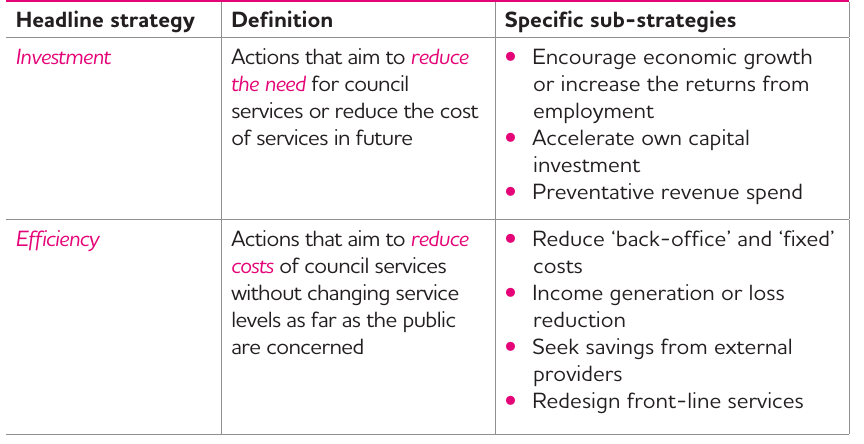
Table 4: Coping with the cuts: headline